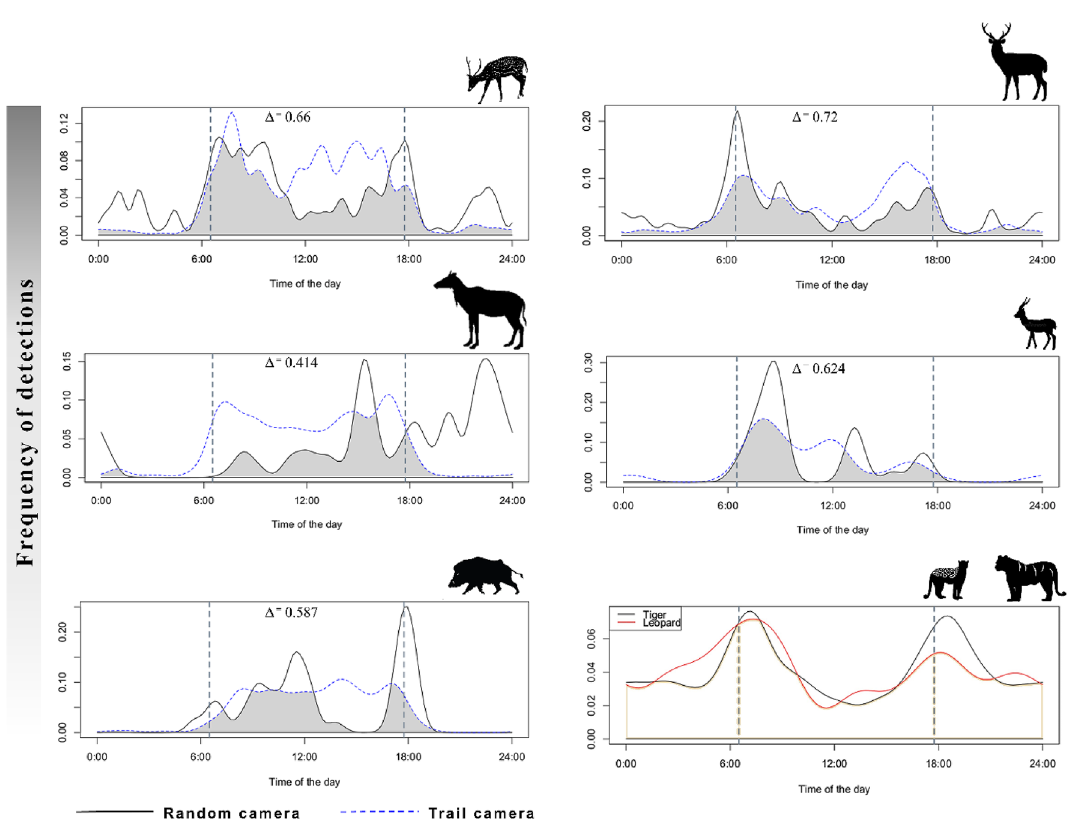
Figure 4. Activity pattern of wild ungulates ( L to R from top: spotted deer, sambar, blue bull, Indian gazelle, and wild pig ) and their major predators ( tiger and leopards ) in the study area. In each graph, the solid-black and dotted-blue line represents the species’ activity pattern obtained from random and trail cameras, respectively; the grey shaded polygons depicted the overlap between two curves. The vertical dotted gray line shows the timing of sunrise and sunset in the study area. Activity pattern of tigers and leopard was computed only from trail